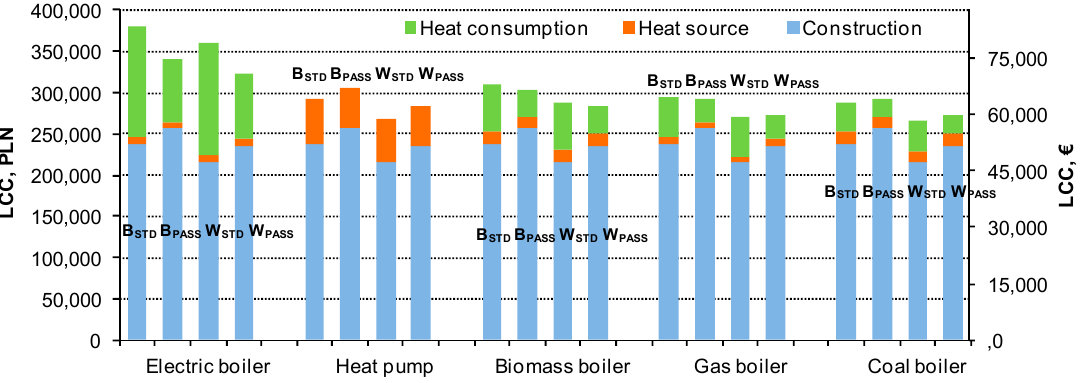
Figure 6. The LCC depending on building type and heat source.